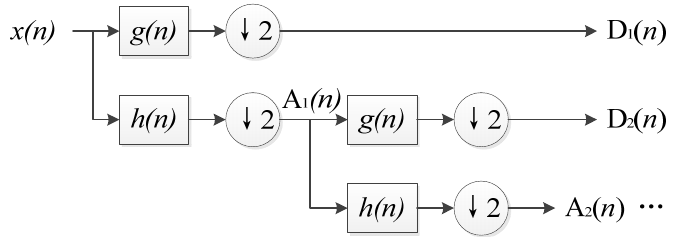
Figure 3. Wavelet decomposition algorithm.